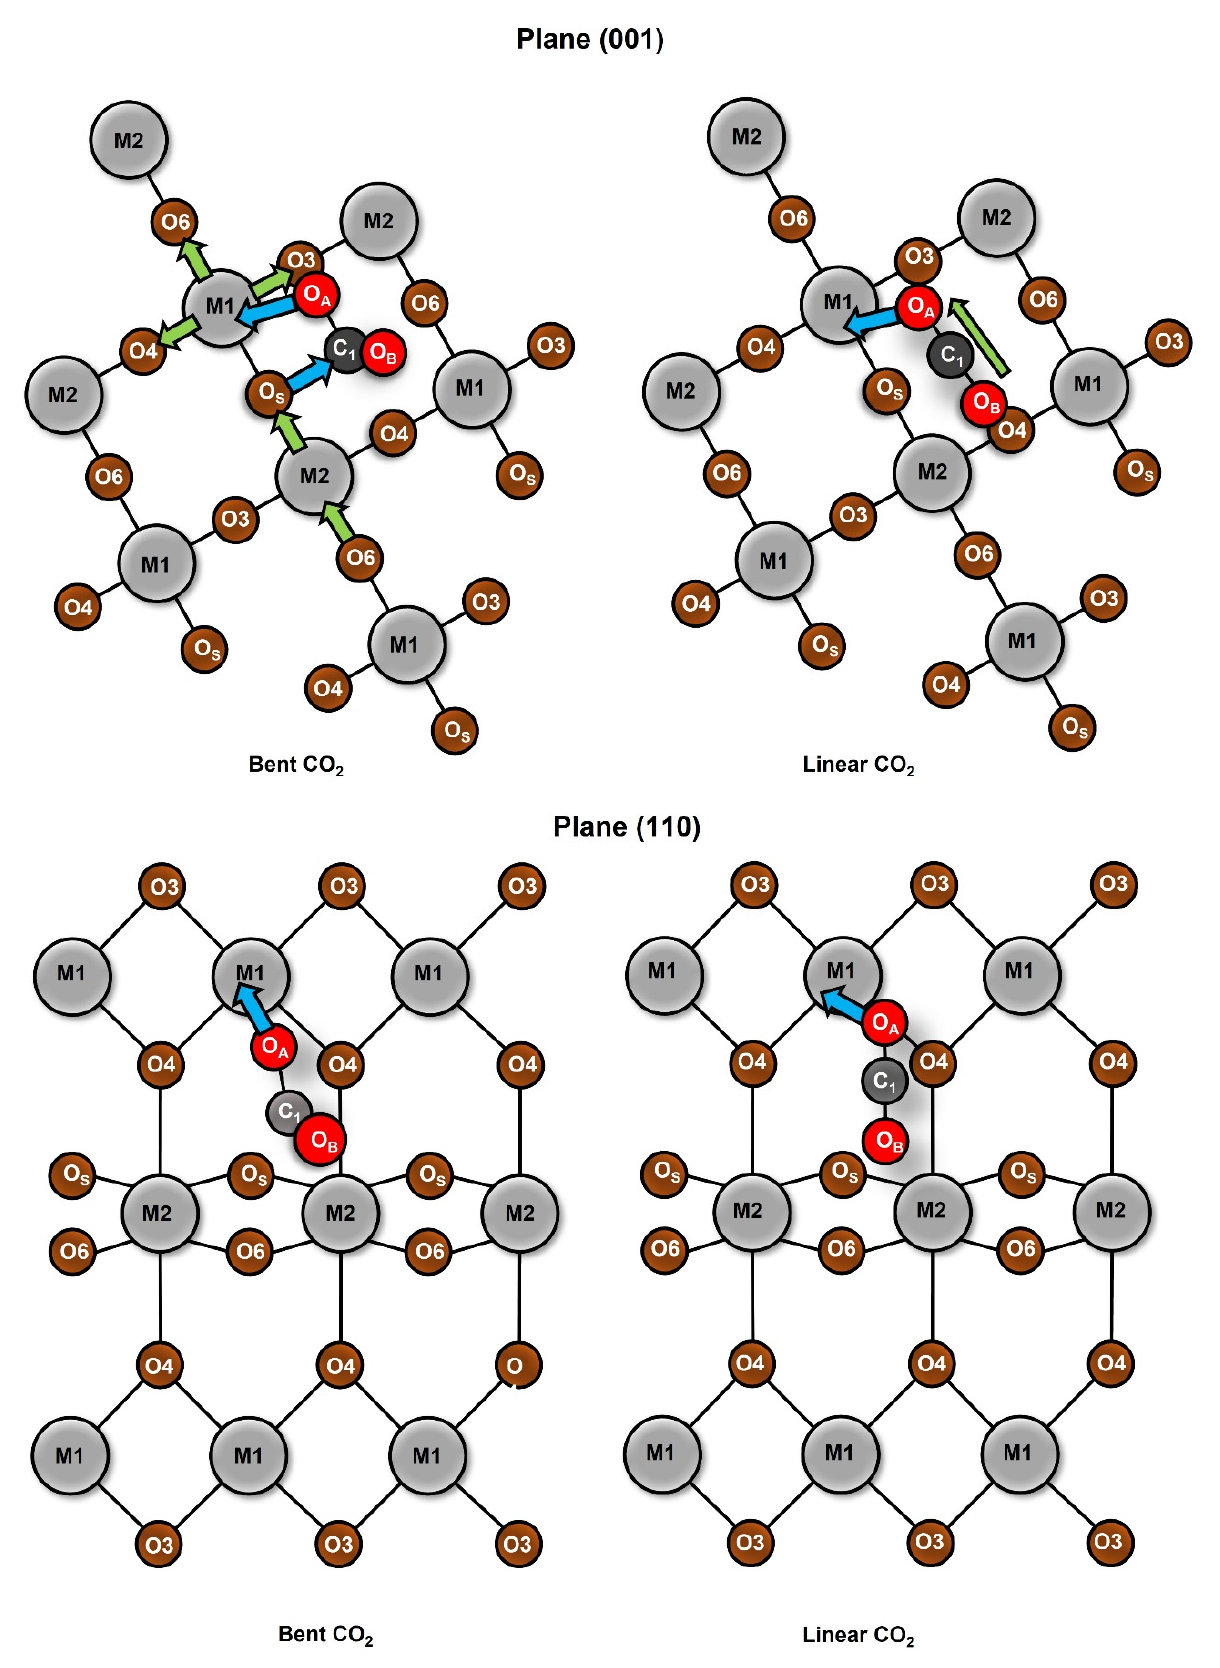
Figure 9. Mechanism of atomic charge redistribution for plane (001) left and (110) right.